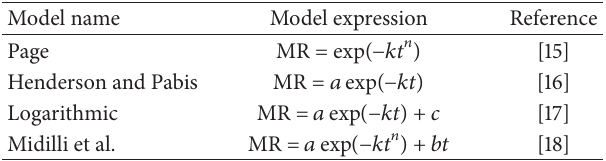
Table 1: Mathematical models that were applied to the experimental data.